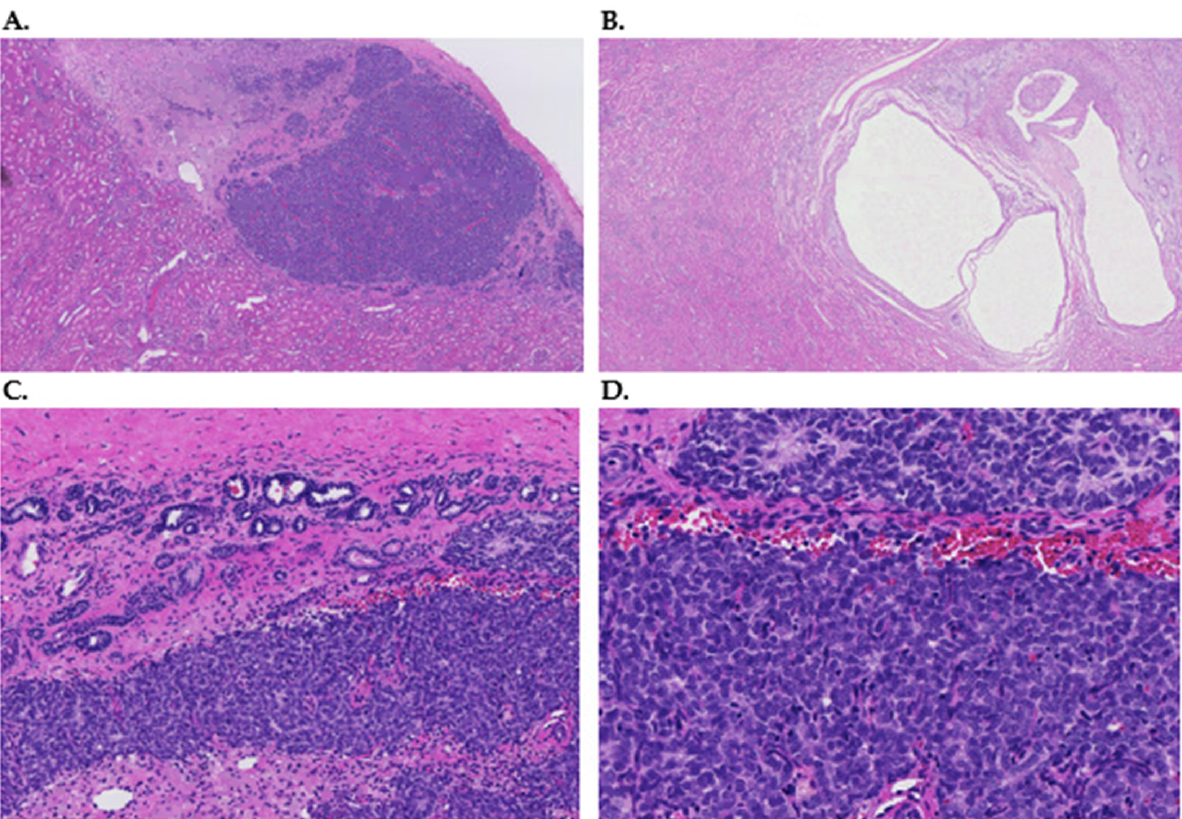
Figure 1. ( A ) Hematoxylin and eosin-stained slide with an overview of a hyperplastic perilobar nephrogenic rest, composed of epithelial structures without cytonuclear atypia of the composing cells. Magnification 2×. ( B ) Hematoxylin and eosin-stained slide with overview of an intralobar nephrogenic rest, composed of cystic structures with some intervening stroma. Both types of rests are surrounded by normal renal parenchyma. Magnification 2×. ( C ) Hematoxylin and eosin-stained section of a 9 mm lesion of the left kidney of 2-year-old male patient for which nephron-sparing surgery was performed. The patient underwent pre-operative chemotherapy according to the UMBRELLA protocol and also had a lesion of the contralateral kidney that was simultaneously removed. The image shows fibrous tissue of the kidney capsule at the top. Below there are glandular structures compatible with epithelial elements of a perilobar nephrogenic rest, as well as a blastemal component with limited nuclear atypia. Magnification 10×. ( D ) Hematoxylin and eosin-stained section of the same lesion as ( C ). This lesion was eventually classified as compatible with a perilobar nephrogenic rest after the careful review of multiple expert pathologists. Please note the bland nuclear morphology of the epithelium and blastema in this close-up image. Magnification 20×.